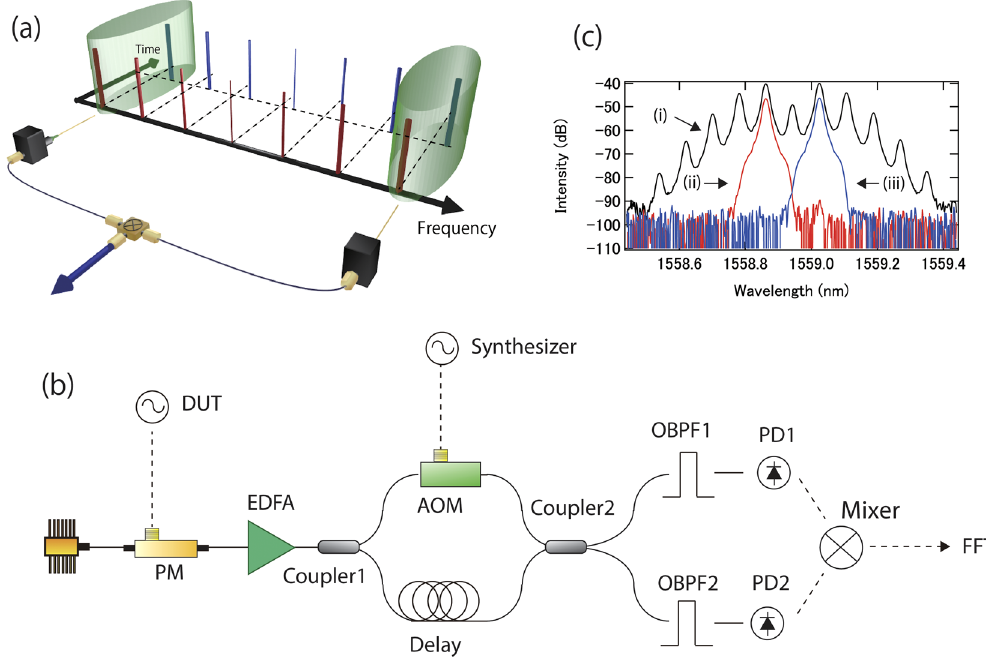
Figure 1. ( a ) Schematic of working principle. Pairs (highlighted by green cylinders) of frequency-shifted (red) and time delayed (blue) EO combs are photo-detected, and mixed. ( b ) Schematic of experimental setup. DUT, device under test; PM, phase modulator; EDFA, Er doped fiber amplifier; AOM, acousto-optic modulator; OBPF, optical bandpass filter; PD, photo detector. ( c ) Optical spectra after the phase modulator (i, black), and optical BPFs (ii, red) and (iii,